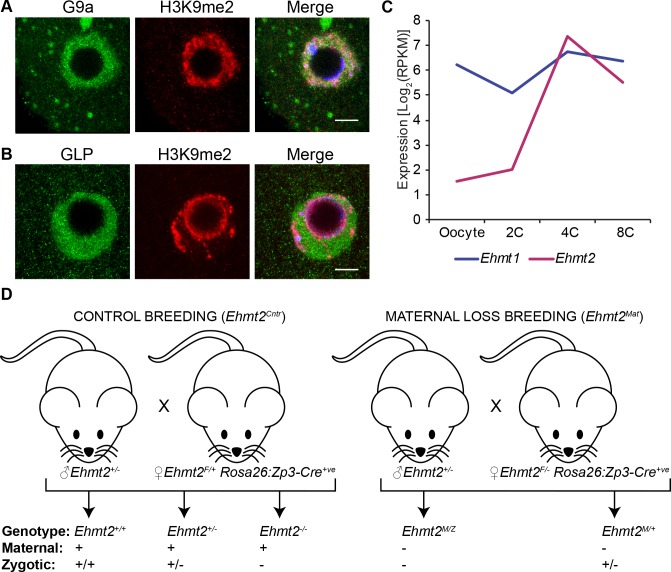
Both G9a and GLP are maternally inherited.(A–B) Whole-mount IF staining on wildtype germinal-vesicle stage oocyte using anti-G9a (A) and anti-GLP (B) antibodies. Shown is a representative image of the germinal vesicle. seven oocytes were imaged per staining. Scale bar = 10 μm. (C) Expression profile of Ehmt1 (encoding GLP) and Ehmt2 (encoding G9a) during early preimplantation development. Dataset used for this this analysis is from GSE22182 (Tang et al., 2011). Presence of both Ehmt1 and Ehmt2 transcripts is detectable (>1 Log2RPKM) at oocyte stage. (D) Schematics of breading plan used to obtain both control embryos (Ehmt2Cntr) as well as maternally depleted ones (Ehmt2Mat). 2C: 2 cell embryo, 4C: 4 cell embryo; 8C: 8 cell embryo; Ehmt2Cntr: control embryos with maternally inherited G9a; Ehmt2M/+ embryos maternally depleted but with zygotic expression of G9a; Ehmt2M/Z embryos without both maternal and zygotic expression of G9a; Ehmt2Mat embryos maternally depleted of G9a; GLP: G9a-like protein; H3K9me2: histone H3 lysine nine dimethylation; IF: immunofluorescence; RPKM: reads per kilobase of transcript per million of mapped reads.